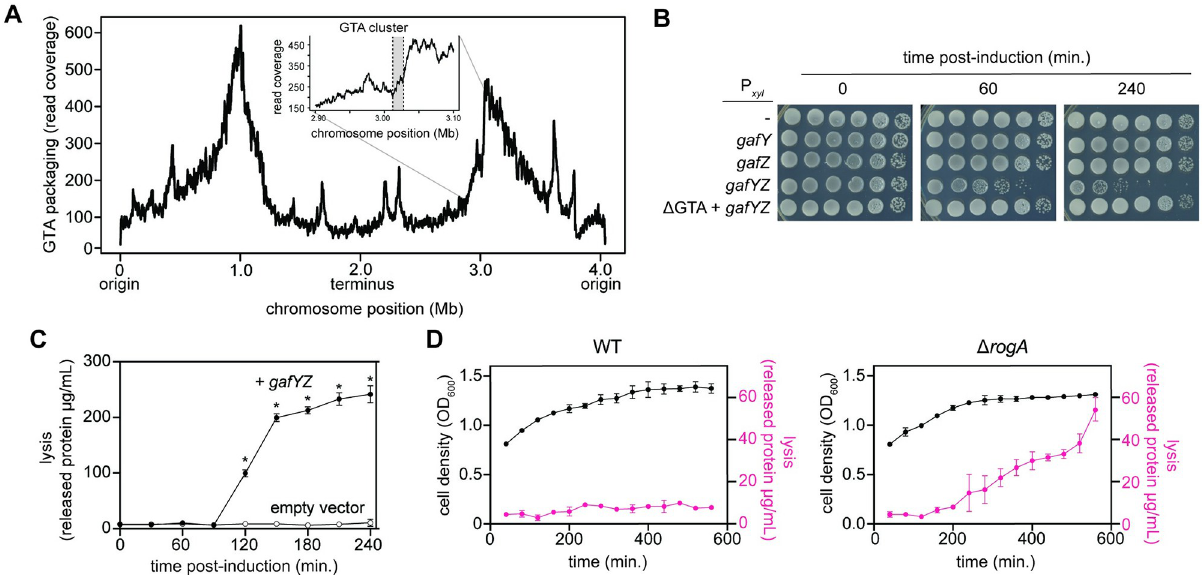
Fig 3. Induction of the GTA cluster leads to GTA packaging and lysis. (A) Long-read (PacBio) sequencing of DNA packaged during GTA production. Inset displays the packaging of the GTA cluster, in gray, and the surrounding DNA. Data are available in S1 Data. (B) Survival of cells bearing high-copy plasmids driving xylose-inducible expression of different genes. Cells were induced with 0.3% xylose and CFUs were enumerated over time. (C) Quantification of released protein content in supernatant during induction of gafYZ over time in strains bearing either P empty vector (white circles) with 0.3% xylose in PYE ( n = 3, error bars indicate SD). � = p -value < 0.05 between data of same time point. Data are available in S1 Data. (D) Quantification of released protein content in supernatant (magenta) as wild-type and Δ rogA cells enter stationary phase ( n = 3, error bars indicate SD). Optical density of cells is plotted in black. Data are available in S1 Data. CFU, colony-forming unit;, GTA, gene transfer